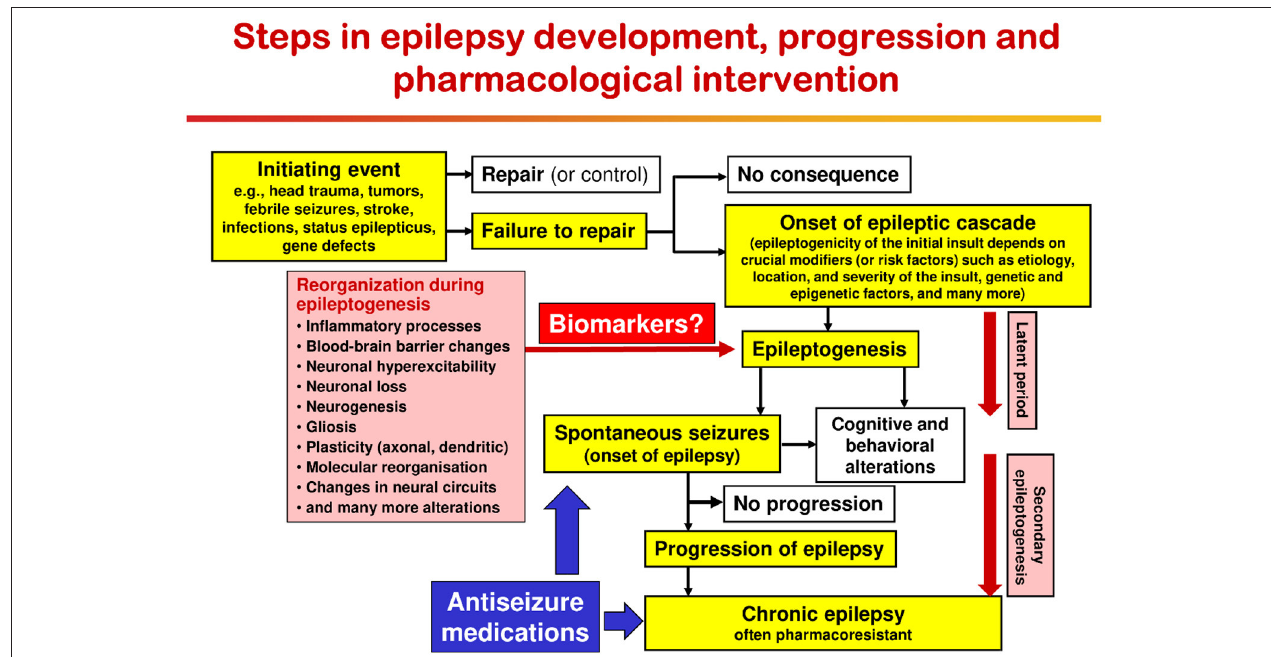
FIGURE 2 | Epileptogenic processes and risk factors involved in the development of epilepsy after acute brain insults. Possibly depending on crucial modifiers or risk factors, the same brain injury can be epileptogenic or not. Immediately after brain injury, early (or provoked) seizures may occur; these acute symptomatic seizures are not indicating epilepsy but may increase the risk of developing epilepsy. In the majority of patients, brain insults do not cause epilepsy. The term epileptogenesis includes processes that render the brain susceptible to spontaneous recurrent seizures and processes that intensify seizures and make them more refractory to therapy (progression or “secondary epileptogenesis”). During epileptogenesis, multiple brain alterations occur, including altered excitability of neurons and/or neuronal circuits, activation of microglia, astrocyte dysfunction, alterations in expression and function of receptors and ion channels (in part recapitulating ontogenesis), loss of neurons, neurogenesis, axonal and dendritic sprouting, gliosis, inflammatory processes, and more. It is important to note that some of these alterations may be related to post-injury repair or recovery and not suited as targets to halt the epileptogenic process. The “latent period” is the time from the initiating epileptogenic brain injury to the first onset of spontaneous clinically obvious seizures. This latent period, during which the epileptogenic processes take place, may last days to months to years. The figure has been modified from previous versions (